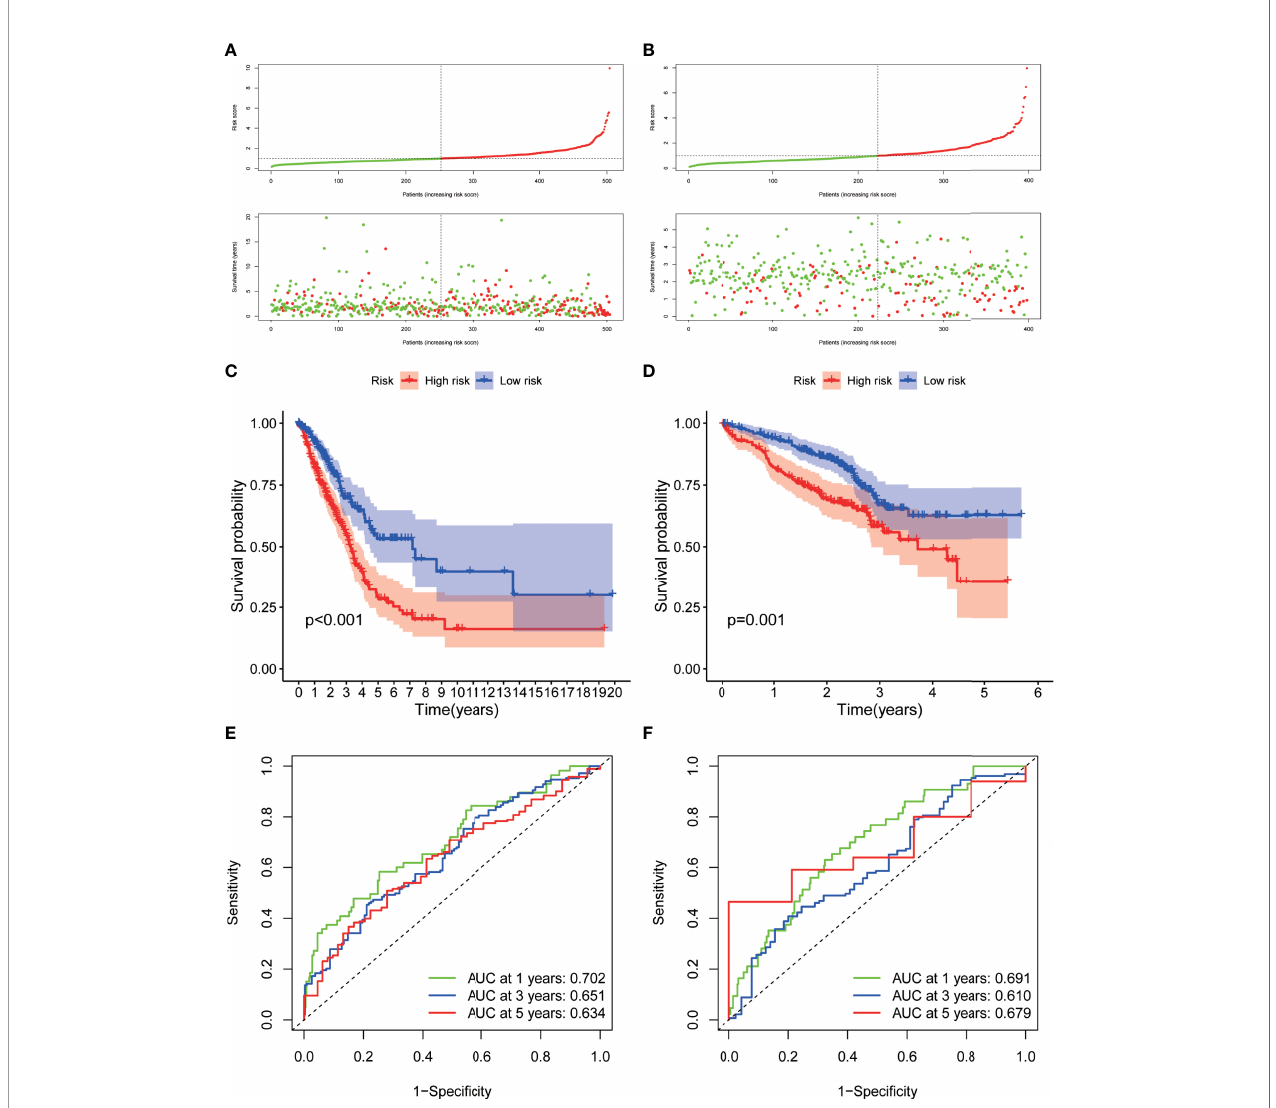
FIGURE 6 | Development and validation of the hub-DRG-based prognostic model (RiskScore) A-B. Risk scores of the DRGs in TCGA cohort (A) and GSE72094 cohort (B) were calculated, and the patients were divided into high-risk group or low-risk group using the median risk score as the cutoff level. Upper panel: patient survival status and time distributed by the risk score. Bottom panel: risk score curves of the DRGs. (C, D) . Differences in overall survival between patients with high RiskScore and low RiskScore in TCGA-LUAD cohort (C) and GSE72094 cohort (D) were assessed using the log-rank test, as shown in the Kaplan – Meier plot. (E, F) . ROC plot showing the prognostic performance of the nomogram demonstrated by the time-dependent ROC curve for predicting the 1-, 3 ‐ , and 5 ‐ year survival rates in TCGA-LUAD training cohort (D) and GSE72094 validation